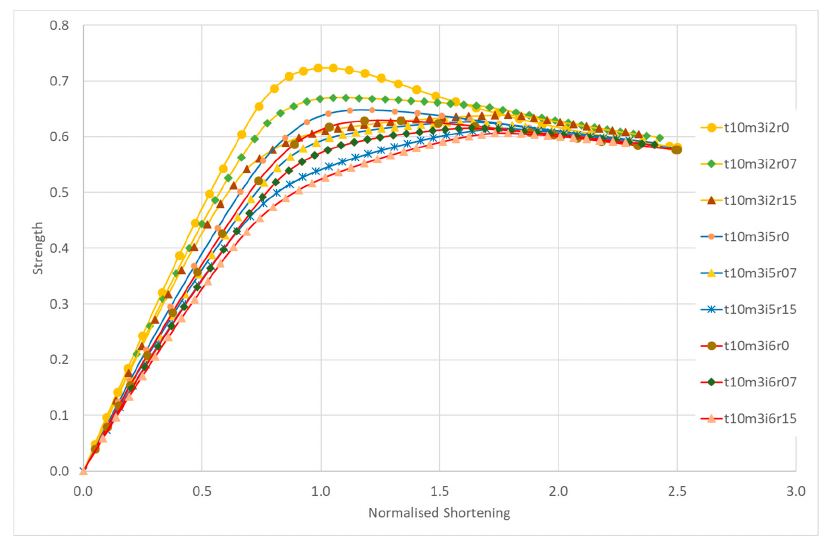
Figure 10. Load shortening curves for intermediate plates ( β = 2.03) with different initial imperfections in critical mode and residual stresses. Table 3. Summary of data and main results for plates with a = 1.5 m, b = 0.6 m and t = 10 mm.